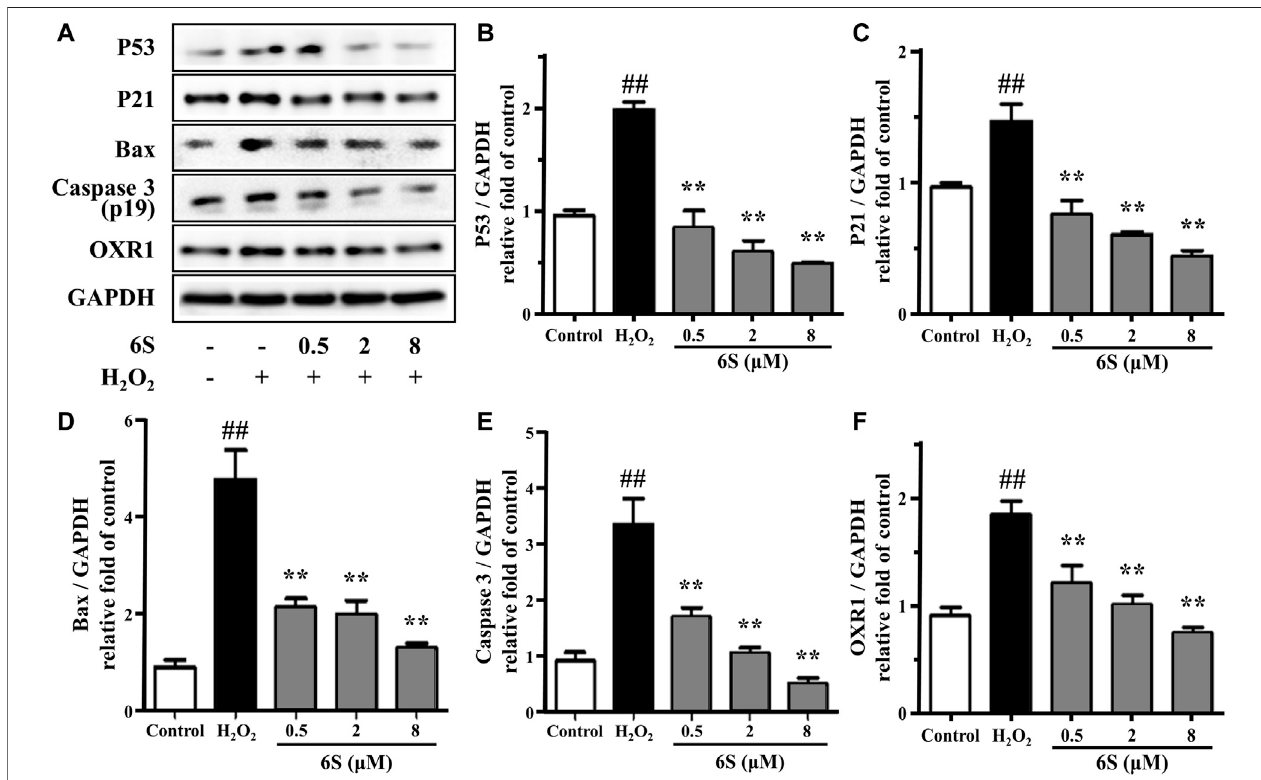
FIGURE2| Theeffectof6Sonproteinexpressionsofp53,p21,BAX,cleavedcaspase-3(p19),andOXR1.VSMCswereincubatedwith0,0.5,2,and8 μ M6Sfor 24 h followed by exposure to 1 mM H 2 O 2 for 2 h. All the data were expressed as mean ± SD ( n = 3). ## p < 0.01 versus control group. ** p < 0.01 versus H 2 O 2 group.